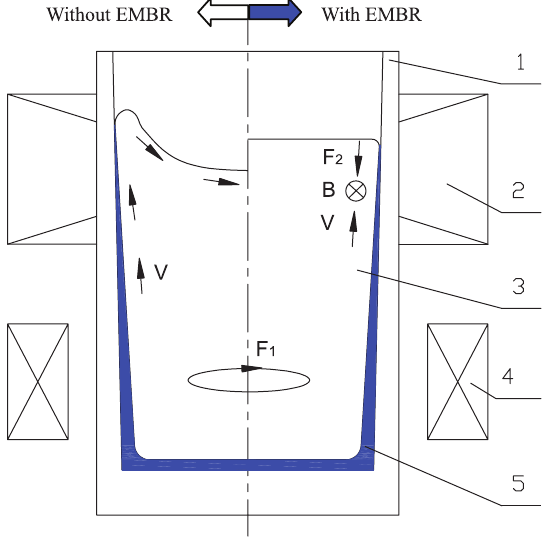
Fig. 3: Influence of EMBR on metal surface fluctuation. (1) Ingot mould; (2) DC field generator; (3) molten; (4) AC rotating field generator; (5)